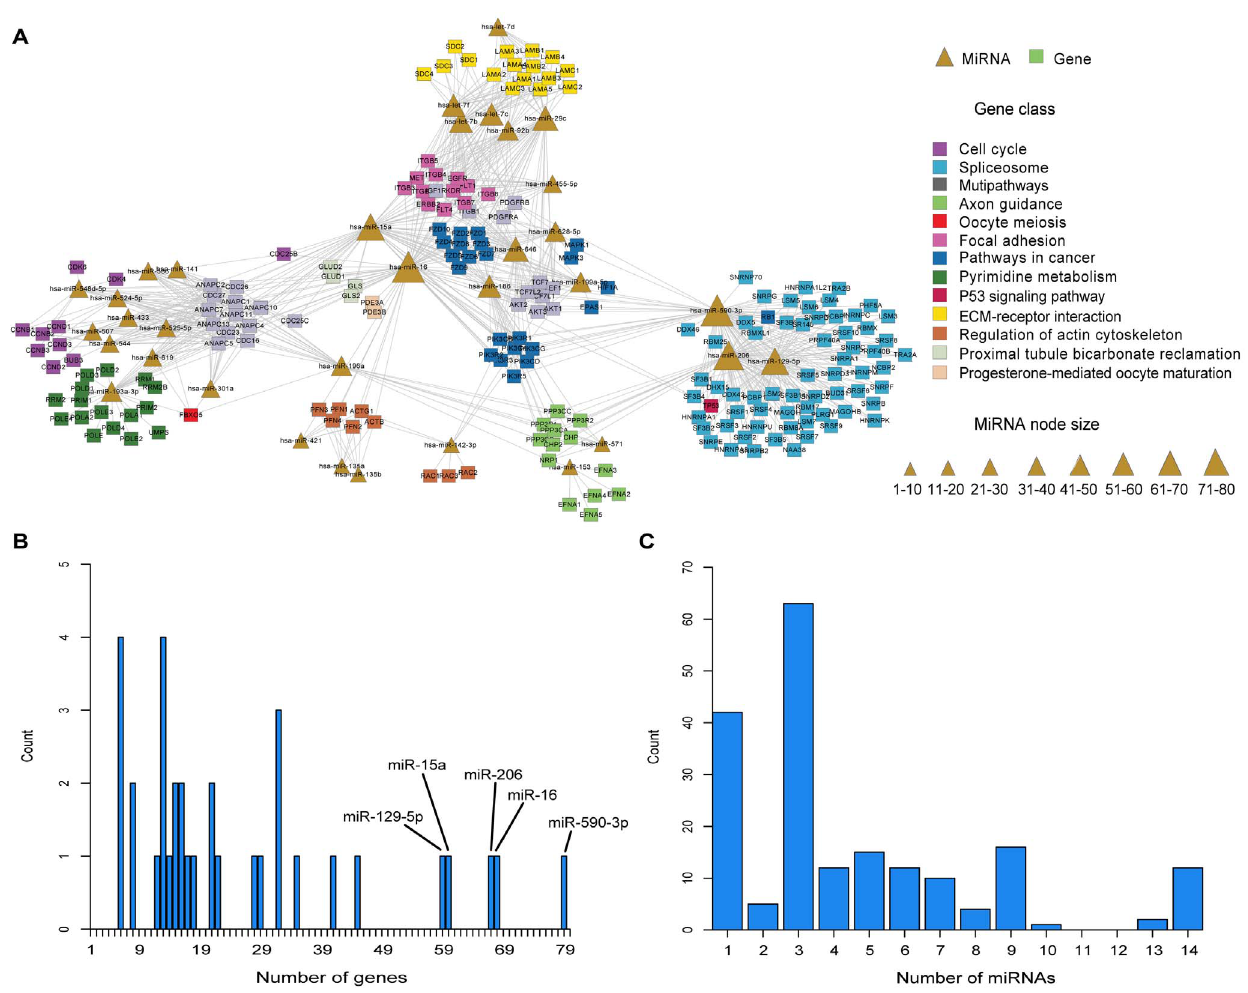
Figure 2. The glioma core survival module and distribution of miRNAs and genes within the module. ( A ). The triangles and rectangles in the core survival module correspond to miRNAs and genes, respectively. MiRNA node size is proportional to the degree of the node. Gene nodes are colored according to their categories, which include 13 pathway classes from KEGG pathway database. ( B ). Distribution of survival related miRNAs with respect to the number of their regulatory genes. ( C ). Distribution of core survival genes with respect to the number of times the gene is regulated by miRNAs.